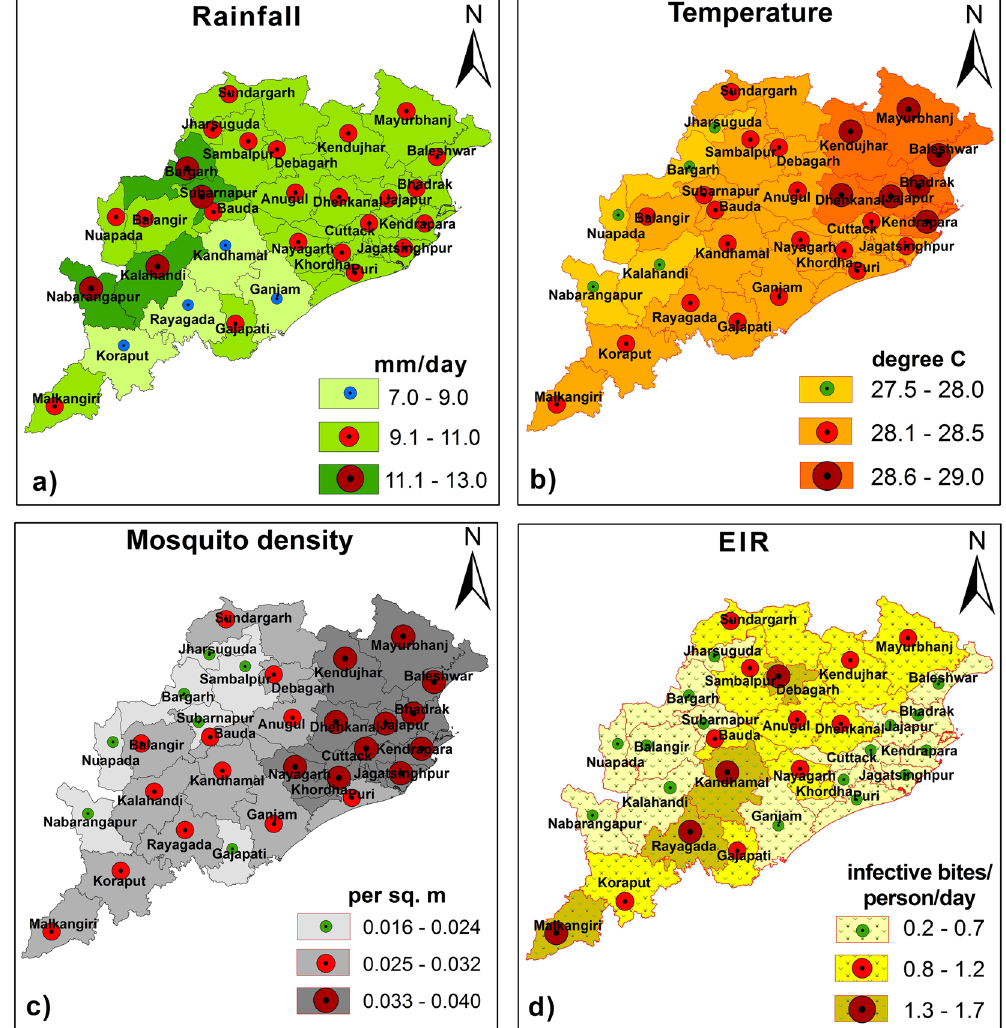
Figure 6. Spatial distribution of VECTRI-simulated. ( a ) Rainfall (mm day − 1 ), ( b ) surface mean temperature (°C). ( c ) Mosquito density (per sq. meter), and ( d ) EIR (infective bites per person per day), during different seasons (pre-monsoon-MAM, monsoon-JJAS and post monsoon-OND), over Odisha (district wise), to understand the effect of seasons on malaria transmission. The maps correspond to the averaging period 2000 to